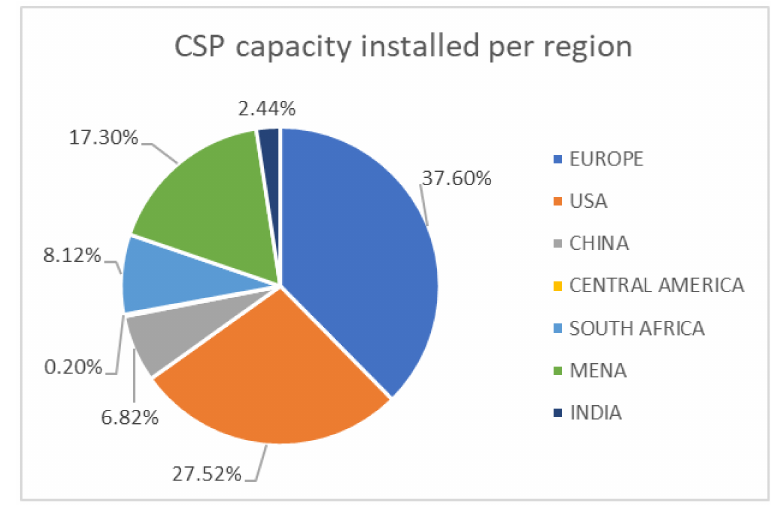
Figure 2. CSP capacity installed per region. Own